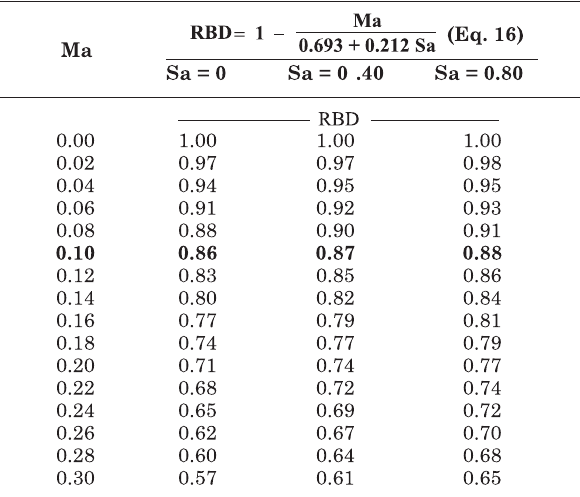
Table 8. Simulation of the relative soil bulk density (RBD) in the macroporosity (Ma) interval 0 - 30 % for sand contents (Sa) from 0 to 0.80 kg kg -1 (0–80